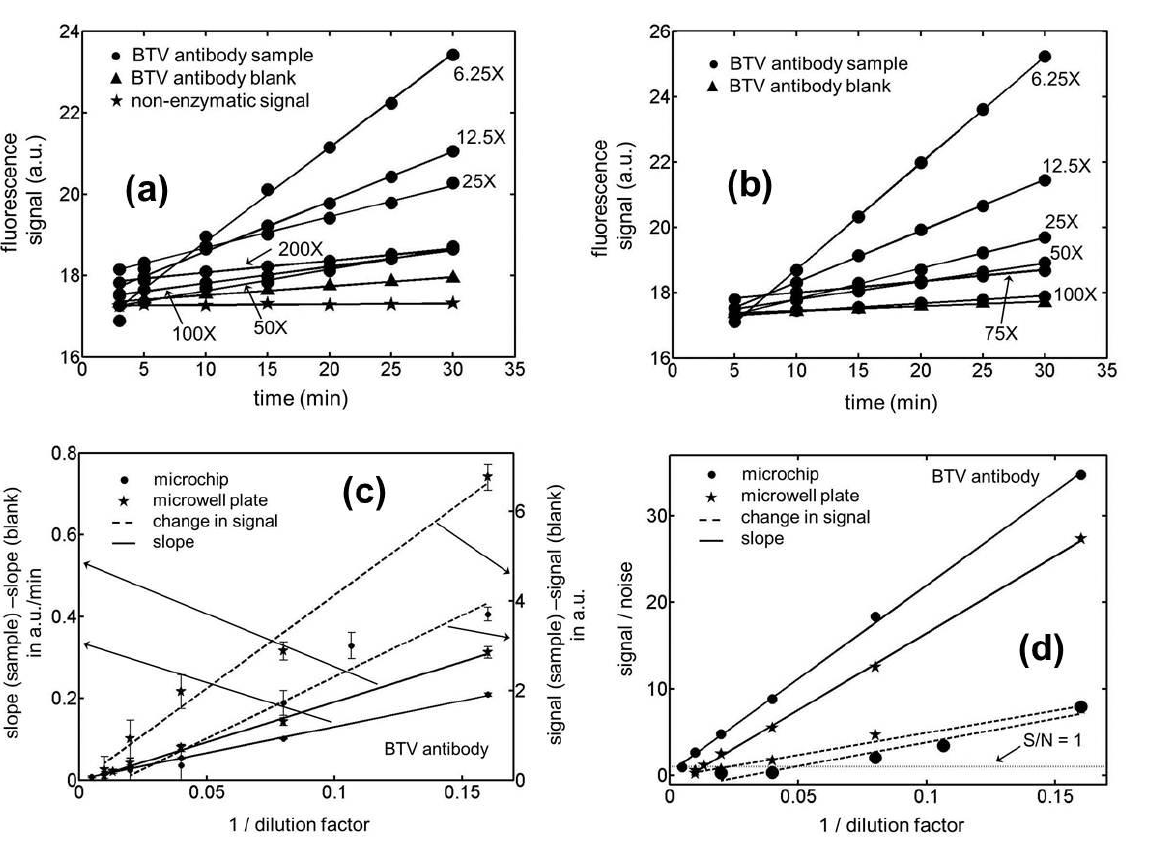
Figure 2. Temporal variation in the fluorescence signal for Blue Tongue Virus (BTV) antibody samples in ( a ) microchannels ( b ) microwells with an active ELISA surface. ( c ) Calibration curves for the kinetic and end-point ELISAs in microchips and microwell plates for BTV antibody samples. Note that while the rate of signal generation for a sample minus that for its corresponding blank (left axis) has been plotted for quantitating the kinetic ELISAs, the absolute change in signal over a fixed enzyme reaction period minus that for its corresponding blank (right axis) was used as a measure for quantitating the end-point immunoassays. ( d ) Limit of detection (LOD) curves for the kinetic and end-point ELISAs in microchannels and microwells for the BTV antibody samples. The noise level (N) in these calculations was evaluated as 3-times the standard deviation in the signal (S). The LOD for an assay was estimated as the dilution factor for which S/N =